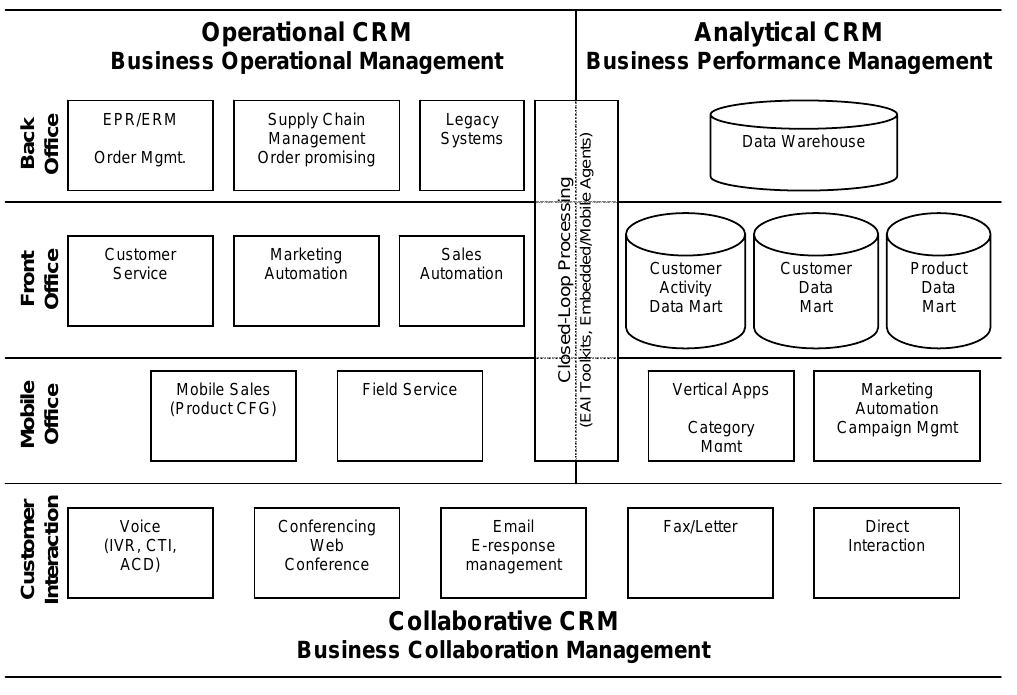
Figure 1: Technology applications of